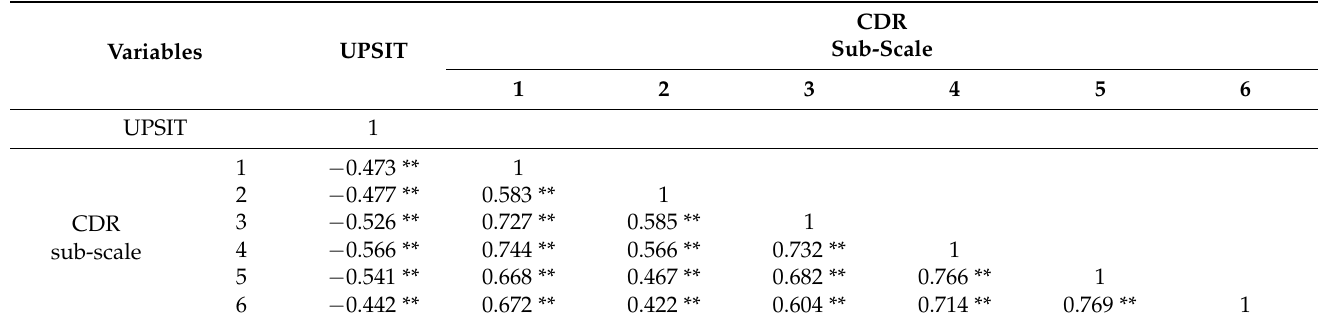
Table 3. Correlation between olfactory function and cognitive